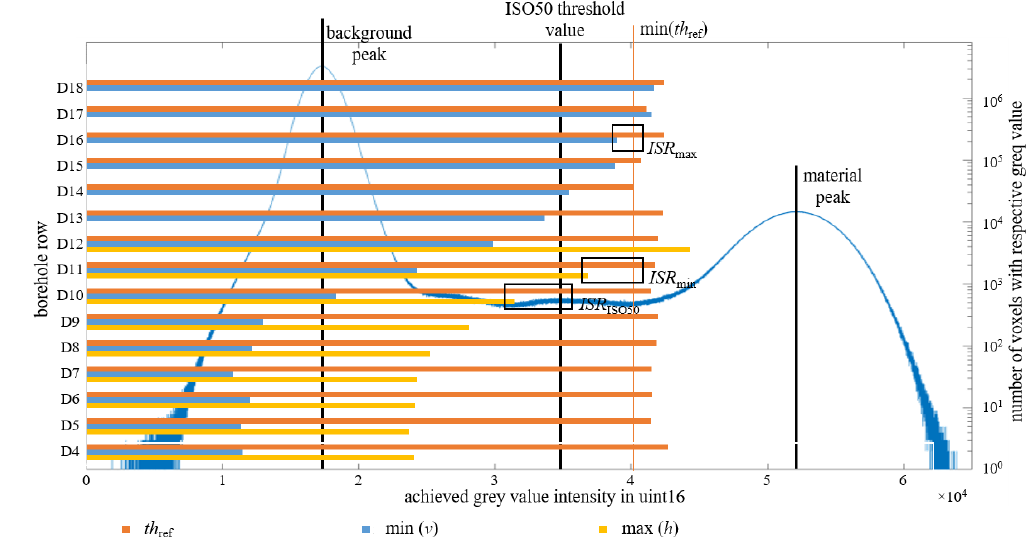
Figure 3. Graphical determination of the interface structural resolution based on relevant extreme values of all borehole rows on the greyscale histogram of the reconstructed volume with system settings S4 and M2.